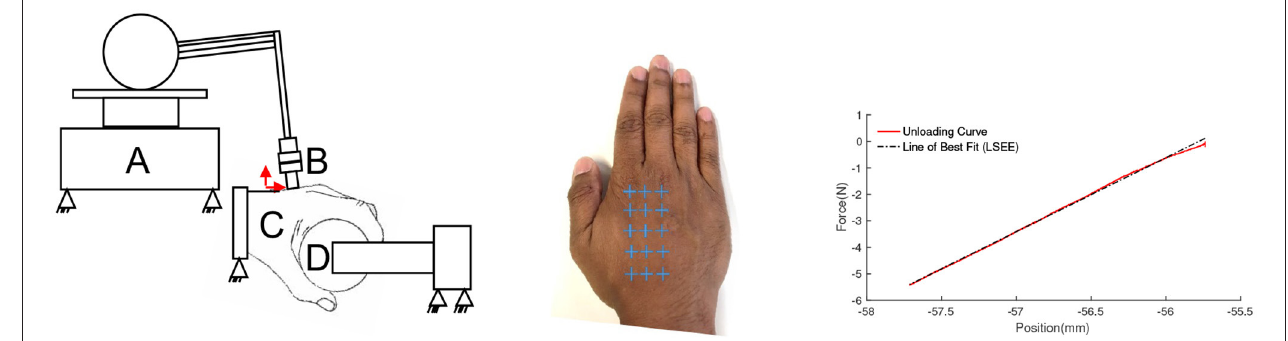
FIGURE 10 | (Left) Phantom premium 1.5 high force haptic renderer (A) , instrumented with an ATI nano 17 6-axis force torque transducer (B) , probing the hand dorsum (C) over a spatial grid while the subject grasps a spherical object instrumented with an ATI Nano 17 (D) . (Middle) Locations of measured stiffness measured over the 2nd & 3rd metacarpal, and 2nd-3rd intermetacarpal region. The blue “+” symbols represent the sites of indentation on the hand dorsum. (Right) Fitting a line to the force deflection curve from indentation experiments. The slope of the fitted line corresponds to the measured stiffness.